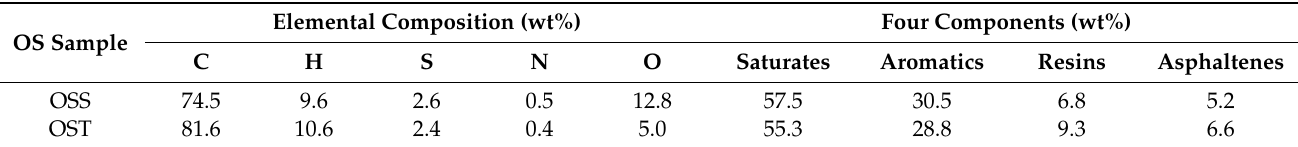
Table 1. Elemental composition and four components of oil in OS.